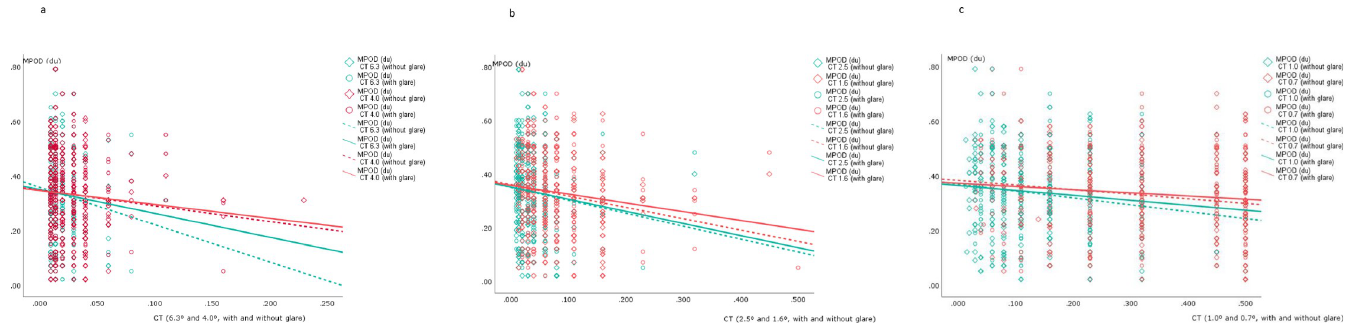
Fig 3. Statistically significant correlations (Spearmn’s rho, ( p value) between MPOD (two eyes/subject, n = 290) and contrast threshold with and without glare (a, b, c).